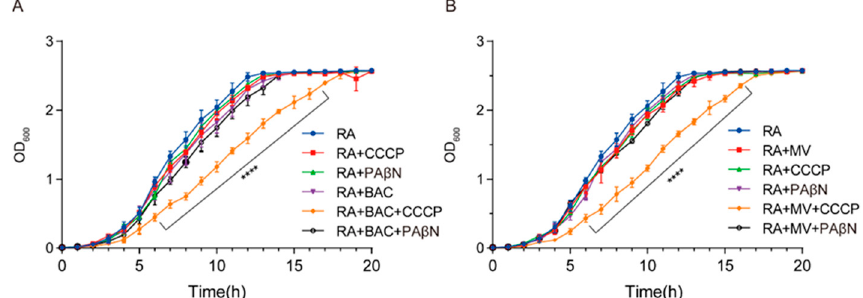
Figure 4. Quantitative susceptibility testing of BAC and MV for the R. anatipestifer strains, in the presence or absence of each EPIs. ( A ) Growth curve of RA-LZ01 strain exposed to BAC in the presence of efflux pump inhibitors. ( B ) Growth curve of RA-LZ01 strain exposed to MV in the presence of efflux pump inhibitors. Growth curves of RA-LZ01 in TSB, TSB + CCCP, TSB + BAC + CCCP, TSB + BAC + PA β N, TSB + PA β N, TSB + MV + CCCP, and TSB + MV + PA β N. Each point represents the mean ± standard for triplicate samples. (**** p < 0.0001).